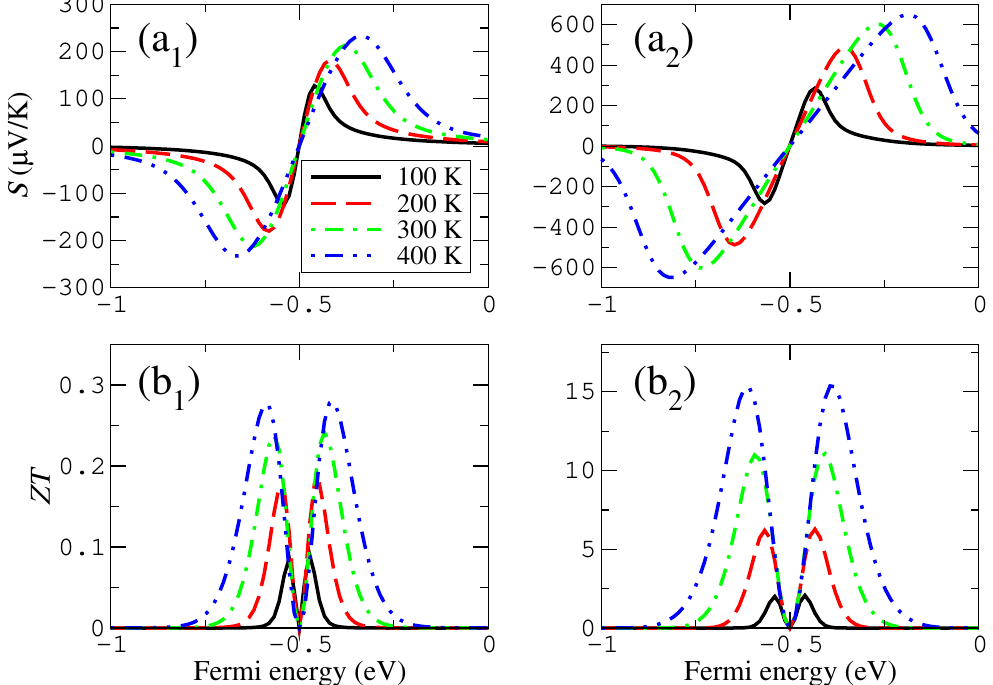
Figure 5. Temperature dependence of the Seebeck coefficient ( a ) and figure of merit ( b ) for the wedge–edge (1) and wedge–wedge (2) configurations. The coupling parameter in this case is − 0.2 eV. Notice that the vertical axis intervals in panels (1) and (2) are